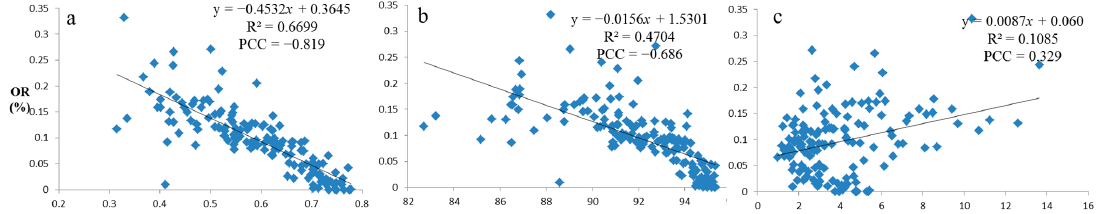
Figure 13. Regression modeling of optimization rate and input factors: ( a ) initial impervious surfaces; ( b ) CN value; and ( c ) slope.